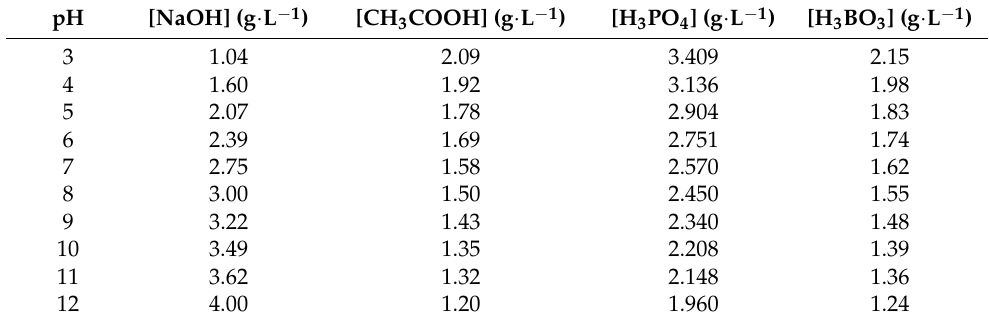
Table 1. Britton–Robinson buffers composition, according to the method reported by Mongay et al. [36].